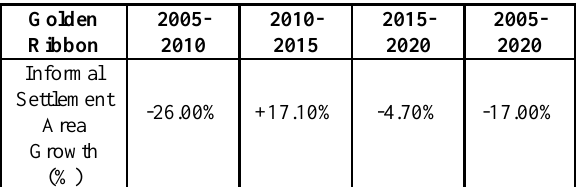
Table 5. Informal Settlement Growth in Percentage in Brgy. Golden Ribbon